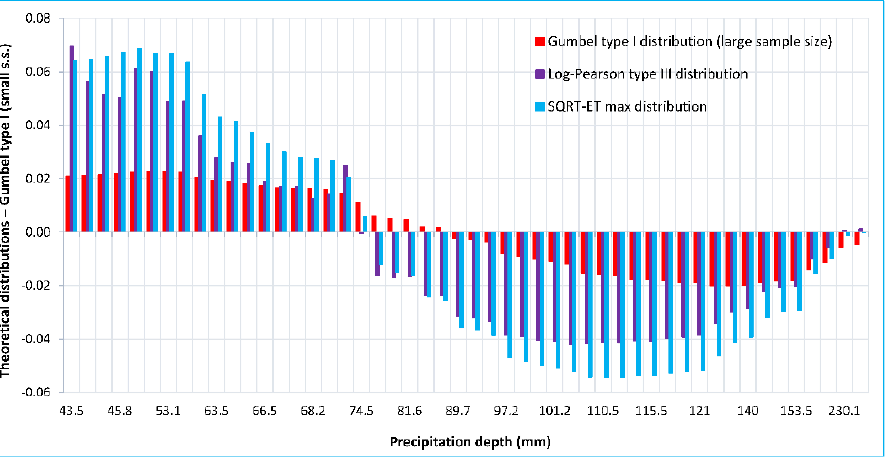
Figure 8. Differences between theoretical distributions with respect to Gumbel type I with a small sample size (small s.s.), as a reference, against precipitation depth.